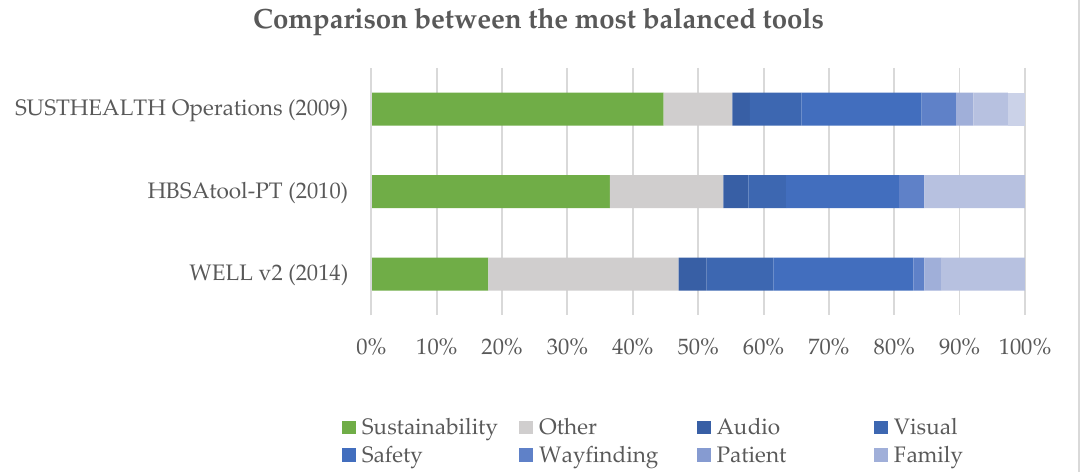
Figure 8. Comparison between the more balanced tools WELL, SUSTHEALTH, and HBSA.